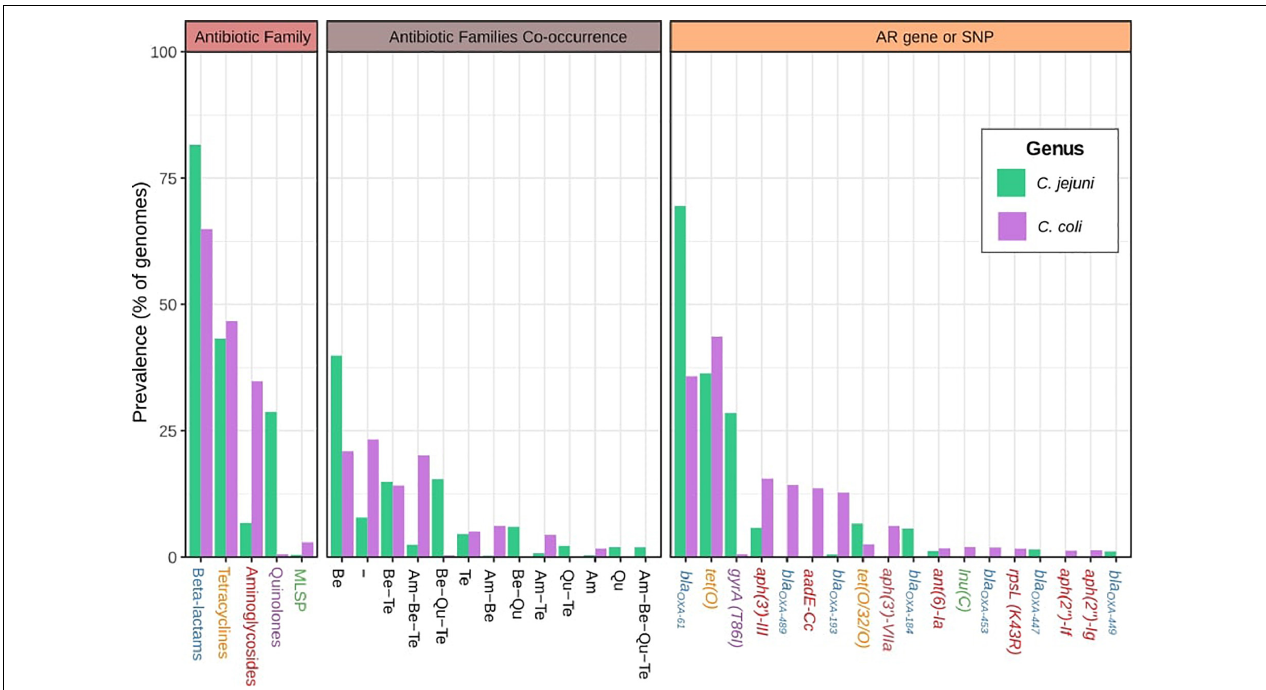
FIGURE 1 | Global antibiotic resistance gene (ARG)-single-nucleotide polymorphism (SNP) distribution on C. jejuni and C. coli genomes. Antimicrobial resistance families, family co-occurrence, and most abundant ARGs or SNPs among the C. jejuni and C. coli genomes analyzed. Am, aminoglycosides; Be, beta-lactams; Qu, quinolones; Te, tetracyclines. Gene names are colored according to the corresponding antimicrobial family [blue: beta-lactams, orange: tetracyclines, red: aminoglycosides, purple: quinolones, and green: macrolides-lincosamides-streptogramins-pleuromutilins group (MLSP)]. Hyphen (-) indicates no ARGs or SNPs